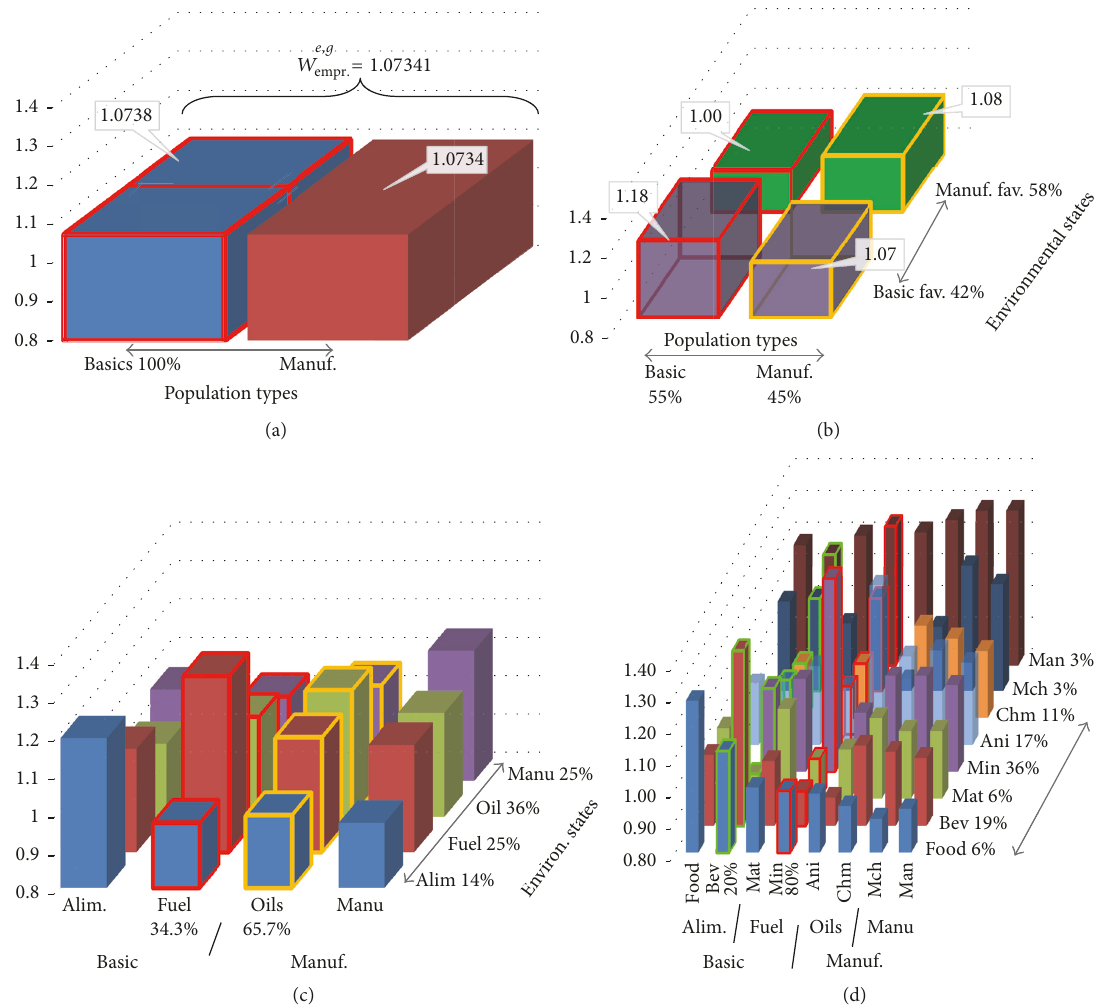
Figure 6: Fine-graining of the Japanese export economy (1974–2010), visualization of selected cases from Figure 5: (a) Space 2 Time 1; (b) Space 2 Time 2; (c) Space 4 Time 4; (d) Space 8 Time 8. Optimization suggests only working with the types that are outlined with colored borders, while neglecting the other